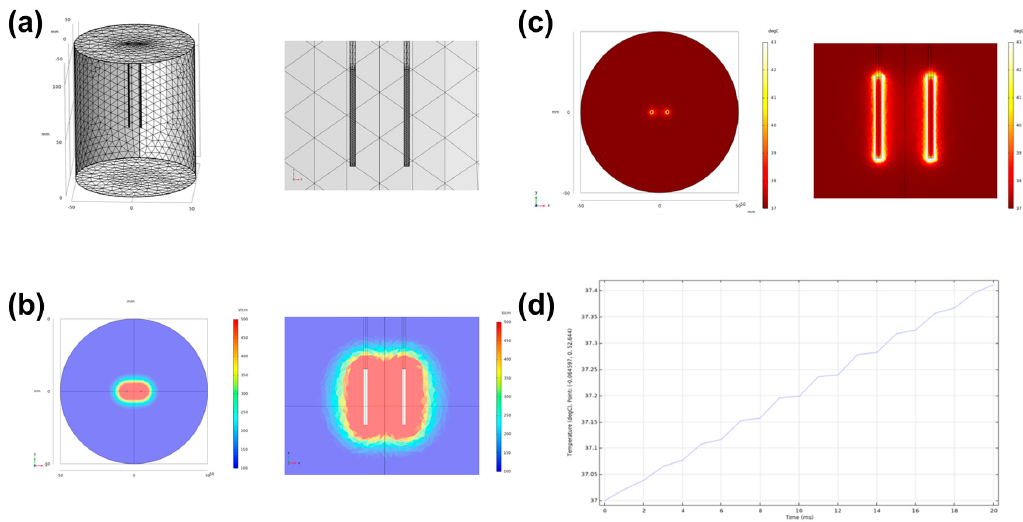
Figure 2. Electric field simulation in the prostate by high-frequency pulsed electric field using COMSOL Multiphysics 5.6. ( a ) Schematic image of monopolar electrodes being inserted into the simulated prostate. ( b ) The electric field strength at the axial- and longitudinal-sections between the two electrodes. ( c ) Thermal distribution at the axial- and longitudinal-sections when 1800 V/cm and 100 μ s width of 10 pulses were applied between the two electrodes. ( d ) Temperature changes at the midpoint between the electrodes.